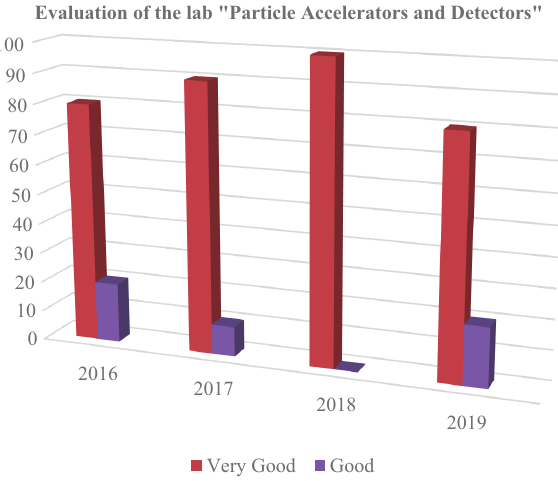
Fig. 6. Anonymous evaluation by primary teachers of the “Particle Accelerators and Detectors” lab at CERN